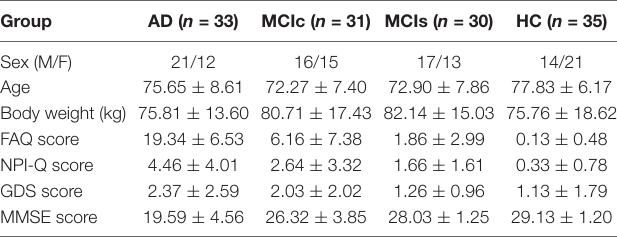
TABLE 1 | Demographic and neuropsychological characteristics of the participants.